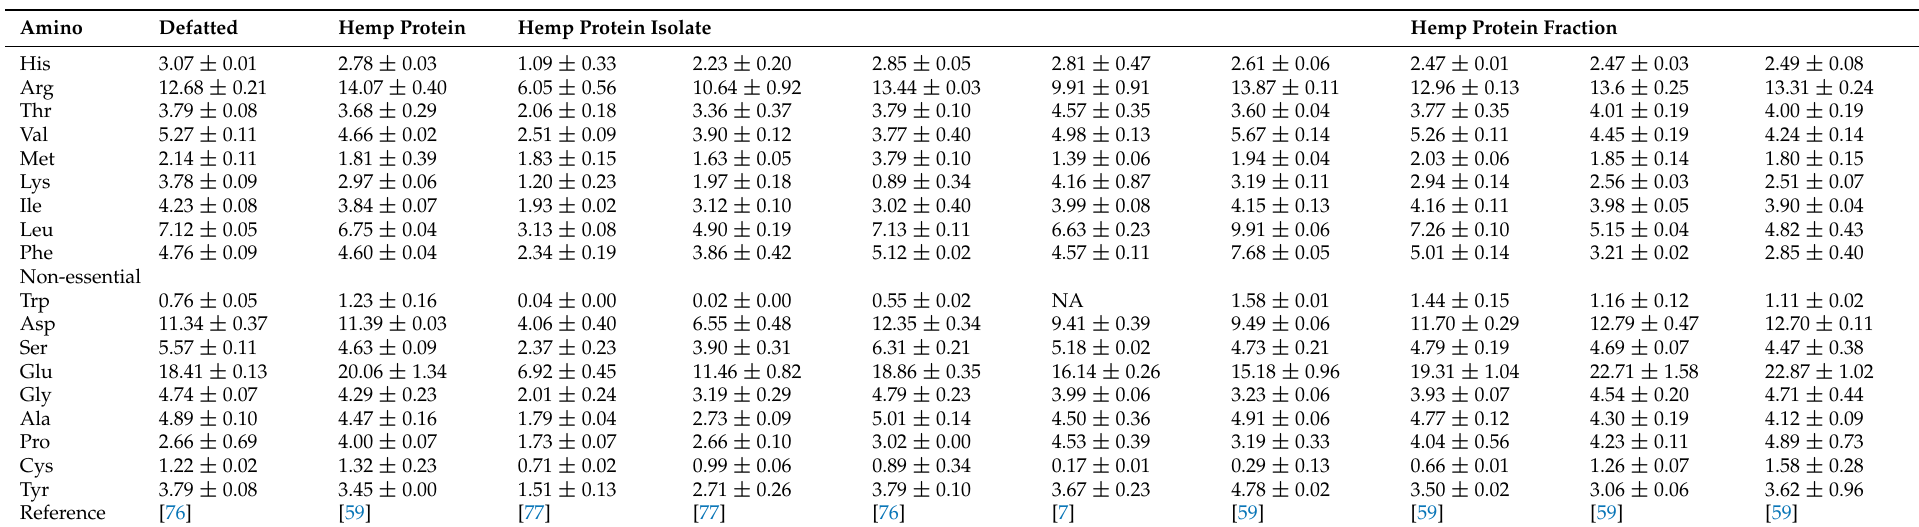
Table 2. Amino acid compositions of hemp proteins and